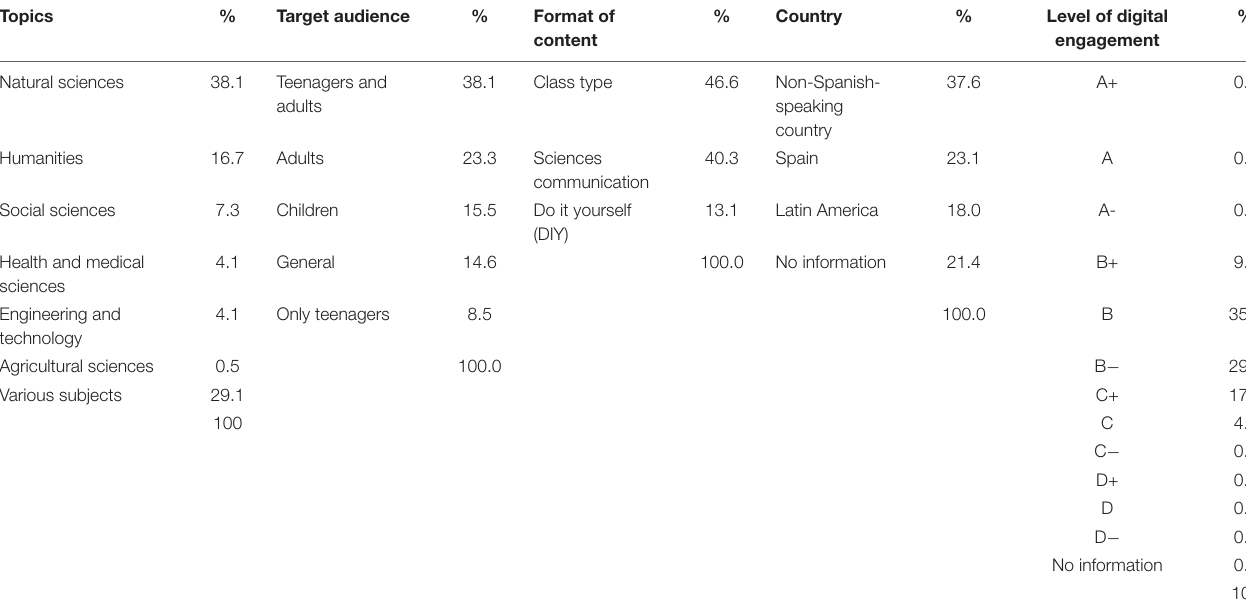
TABLE 1 | Attributes and categories for each educhannel.